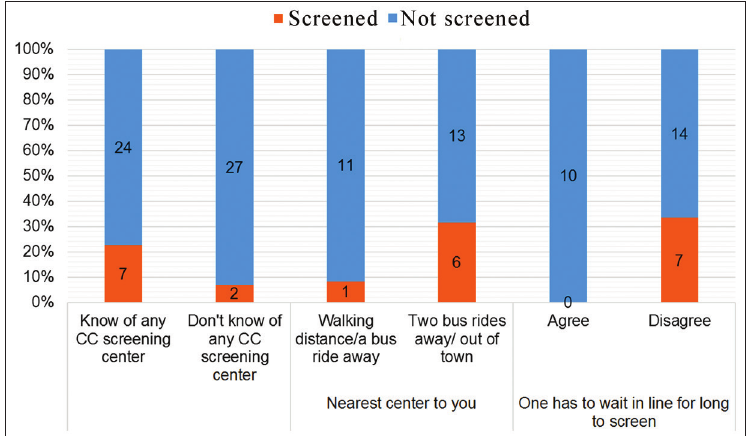
Figure 2 : Accessibility factors associated with cervical cancer